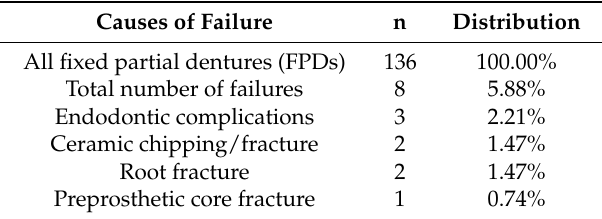
Table 6. Reasons for biological or technical failure of FPD restorations.